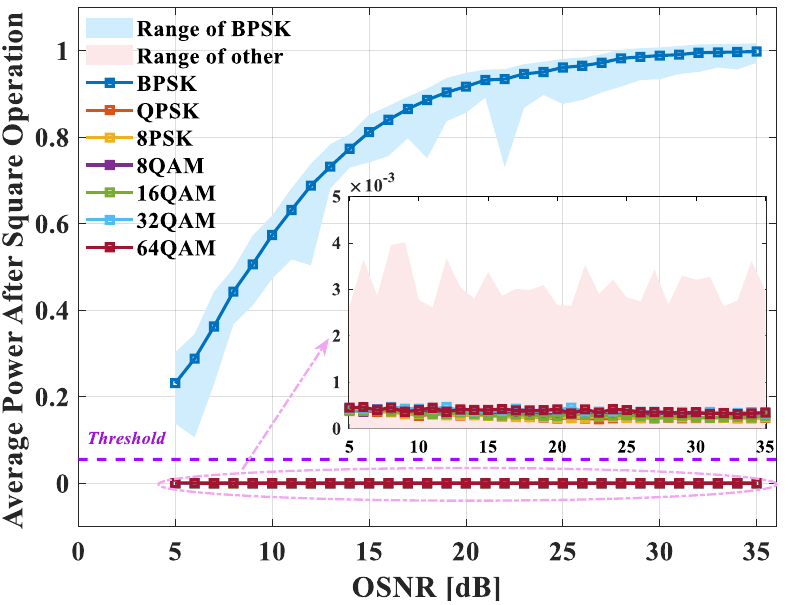
Figure 6. The average power of signals after the square operation.